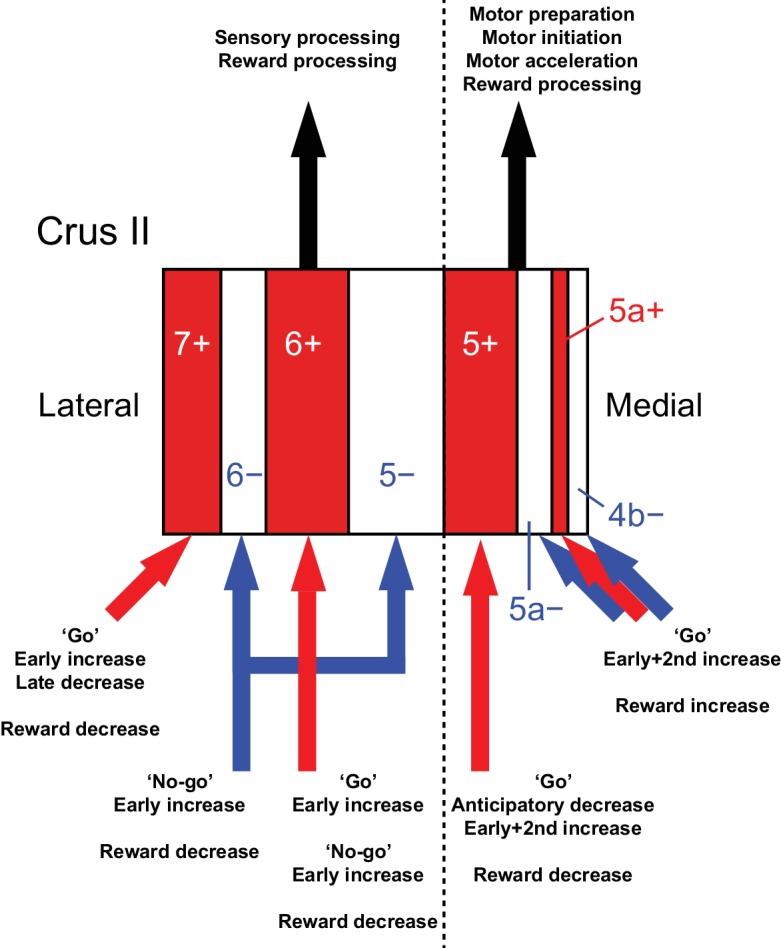
Diversity of CF signals across the entire Crus II and their functional implications.A schematic of our main findings. Red and white stripes represent AldC+ and AldC− compartments, respectively. A dashed line represents the functional boundary of lateral and medial Crus II. Red and blue arrows represent CF inputs to each compartment. Black arrows represent outputs from lateral and medial Crus II.